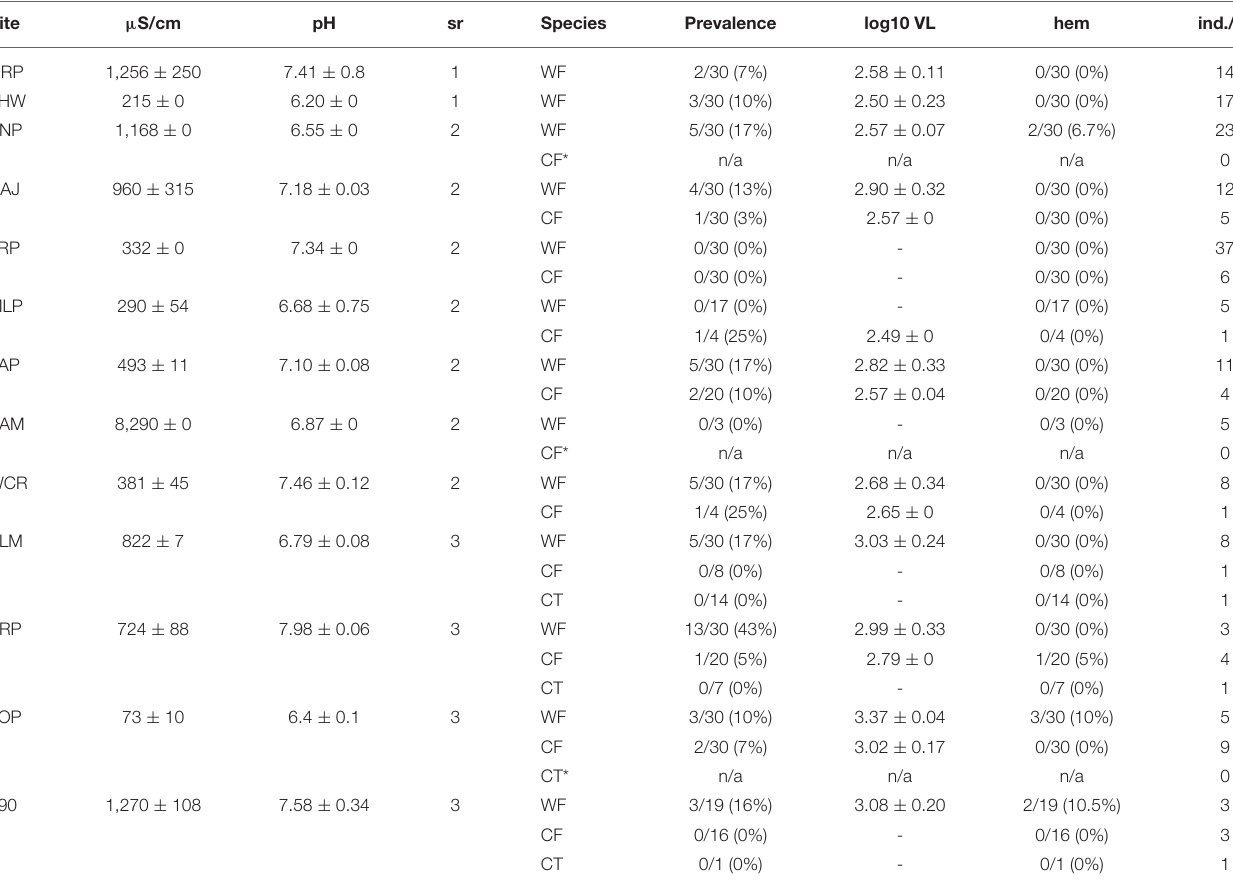
TABLE 1 | Field sites in Alberta and the Northwest Territories where terrestrial amphibian life stages were sampled for ranavirus in 2016. Site µ S/cm